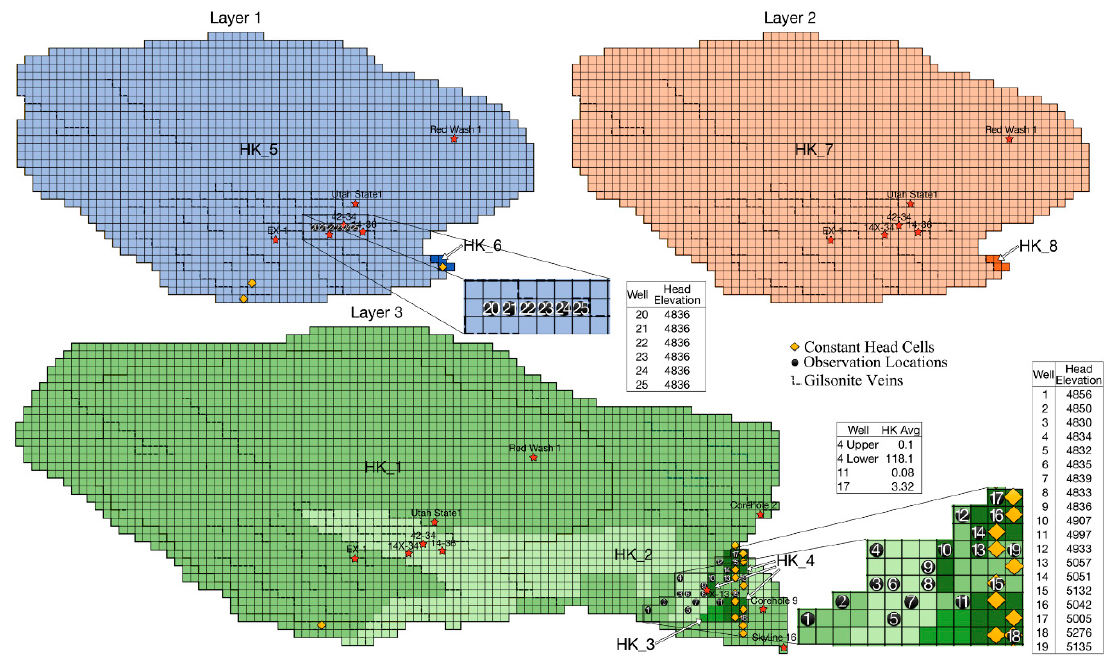
Figure 2. Three-layer Birds Nest Aquifer (BNA) model constant head cells, observation locations, layers, and horizontal conductivity zones (indicated by different shades and HK_#). Inset closeups of observation well locations and adjacent tables of observed head elevations. Inset table of average conductivity estimates from well drawdown tests.